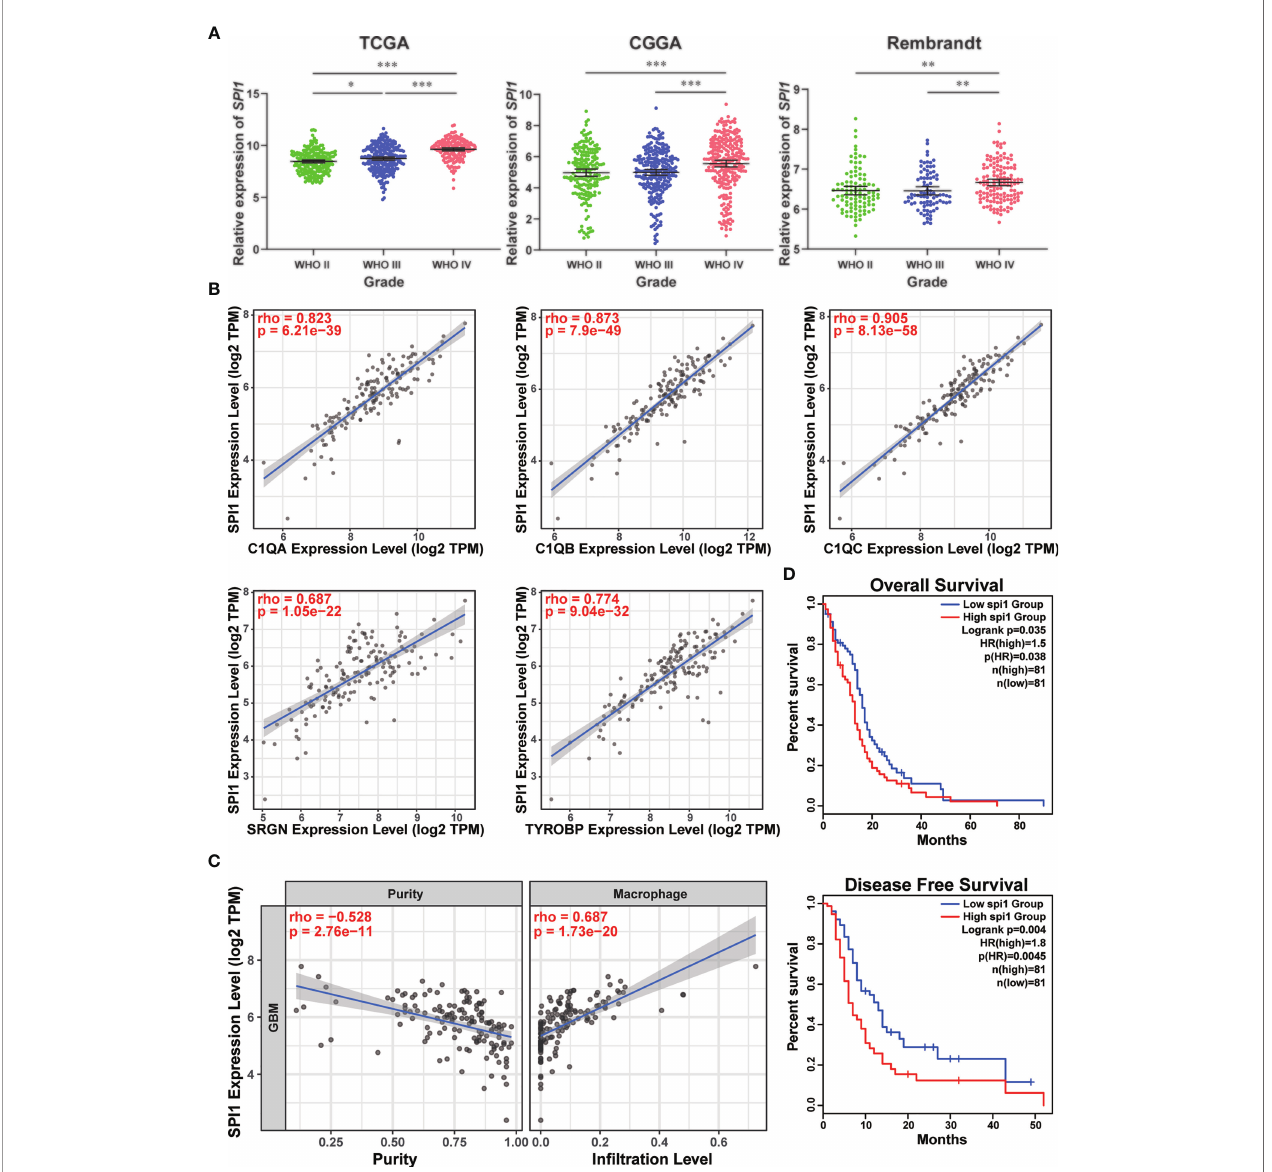
FIGURE 6 | High expression of SPI1 correlated with upper macrophage in fi ltration and poor prognosis in GBM. (A) The expression levels of SPI1 in different WHO groups were calculated and visualized as scatter plots. *p < 0.05, **p < 0.01, ***p < 0.001. (B) The expression of SPI1 was positively correlated with marker genes in the TAM group. (C) The SPI1 expression was negatively correlated with tumor purity and positively correlated with macrophage in fi ltration. (D) The correlation between SPI1 expression and survival prognosis of GBM in TCGA. The OS and DFS maps were